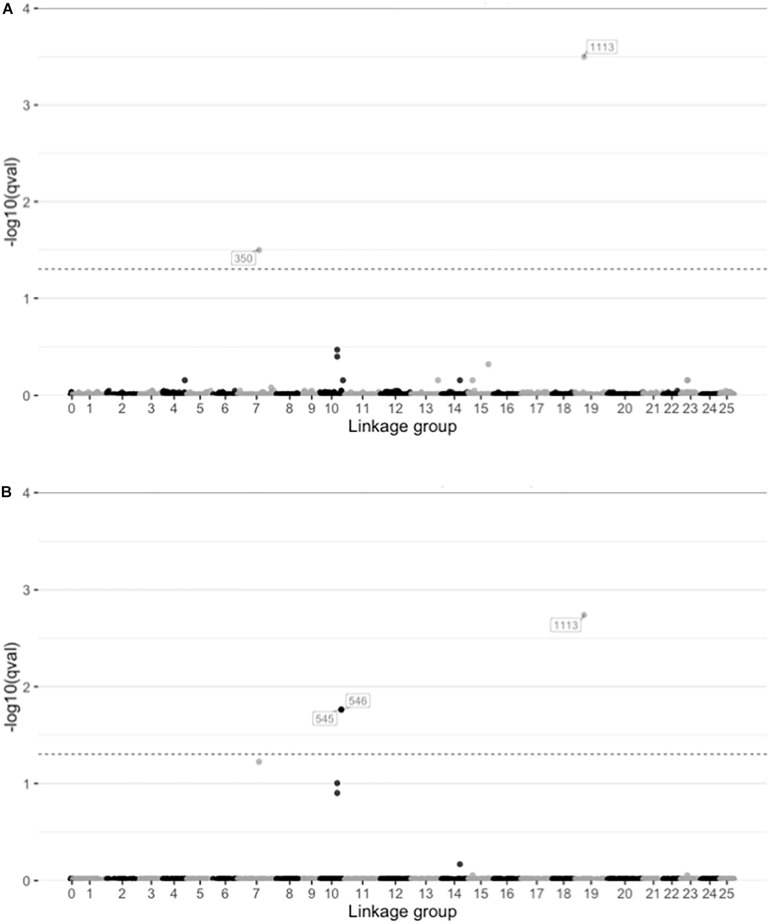
Plots showing the results from latent factor mixed model (LFMM) analysis of SNPs correlated with environmental variables. Plots show the -log10 q-values for each SNP distributed along the linkage groups (linkage group 0 indicate unplaced scaffolds) for two environmental variables (A) salinity in the spawning ground, and (B) temperature at initiation of spawning. The dashed lines indicate significance threshold (q = 0.05).